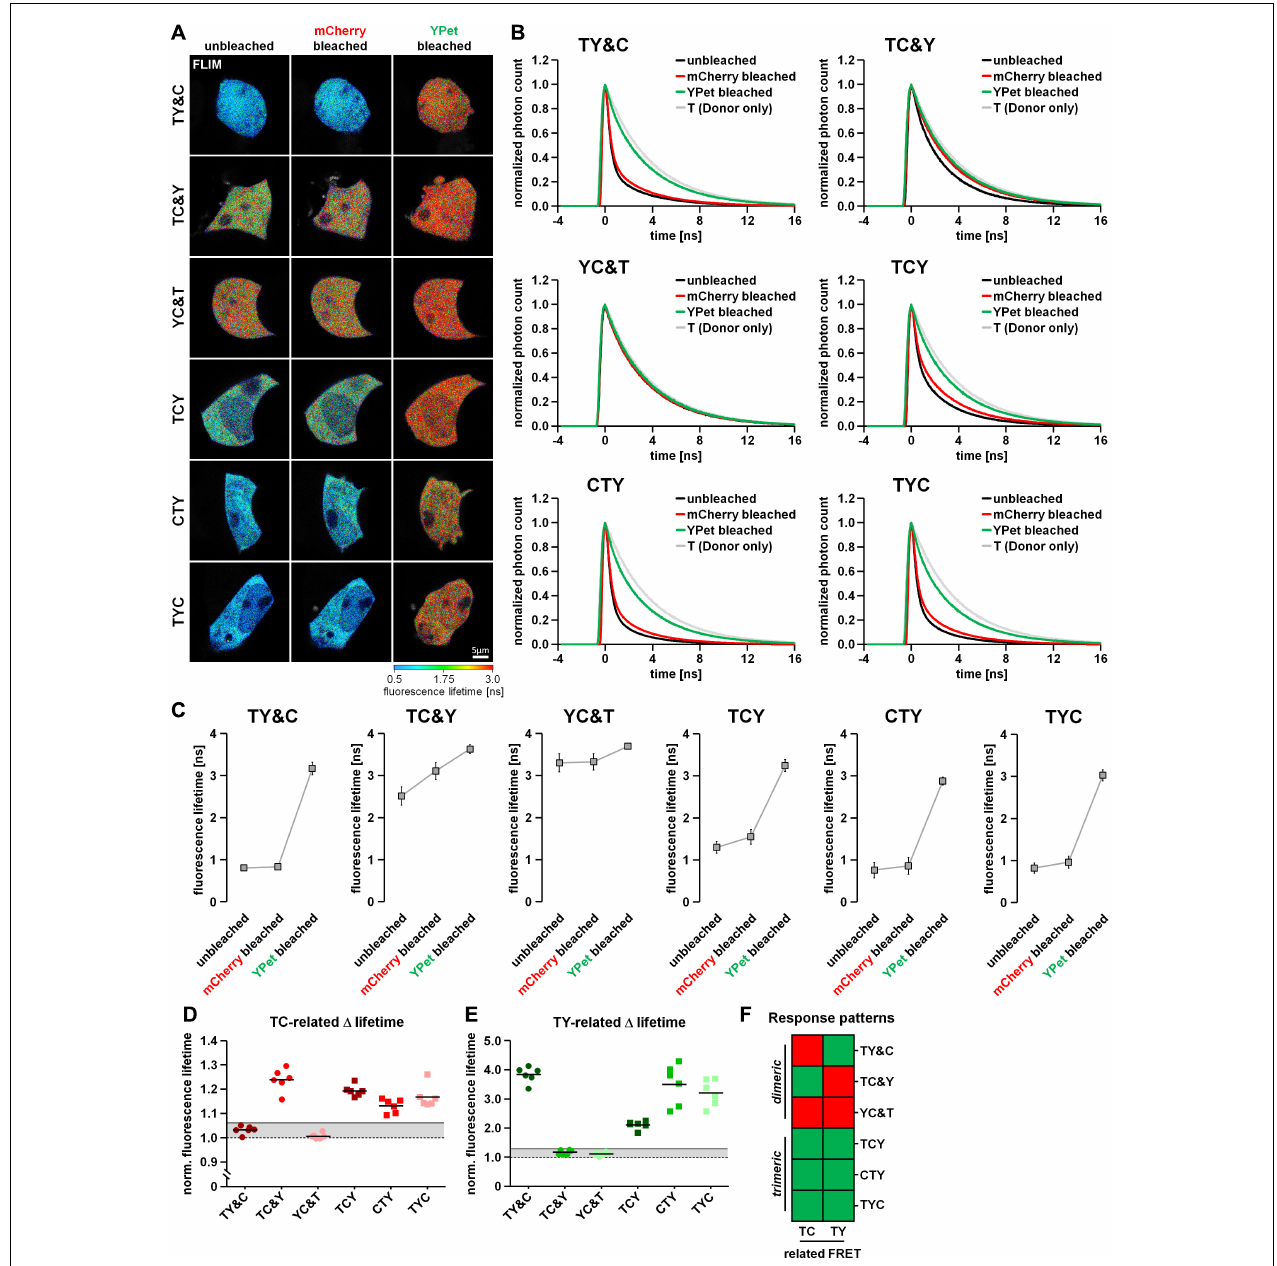
FIGURE 3 | Differentiation of dimeric and trimeric interactions using fluorescence lifetime-based measurements. (A) HEK293T cells transfected with either the FRET triplet constructs (TCY, CTY, TYC) or the FRET doublets with their respective missing fluorophore (TY&C, TC&Y, YC&T). Representative images show the color-coded fluorescence lifetime of mTurquoise2 before bleaching (unbleached), after the first bleaching step (mCherry bleached) and after the second bleaching step (YPet bleached). (B) Average profiles of mTurquoise2 fluorescence decay ( n = 6). Note the sequential reversion of the FRET-induced left shift of mTurquoise2 fluorescence decay after the first and the second bleaching step. (C) Change in average amplitude weighted lifetime of the cells during the two-step bleaching protocol ( n = 6). After mCherry bleaching, the fluorescence lifetime increased moderately in TC&Y and slightly in TCY, CTY and TYC samples, whereas it remained rather constant in TY&C and YC&T samples. In contrast, after YPet bleaching, the fluorescence lifetime increased drastically in TY&C, TCY, CTY and TYC, whereas in TC&Y and YC&T samples only a moderate increase was observed. Note the different basal fluorescence lifetime depending on the combination and composition of the FRET constructs. (D,E) Relative change in fluorescence lifetime of mTurquoise2 after mCherry bleaching [TC-related (cid:49) lifetime, (D) ] and the additional relative change in fluorescence lifetime after YPet bleaching [TY-related (cid:49) lifetime, (E) ] ( n = 6). Gray lines indicate threshold values to discriminate FRET-specific from non-specific lifetime changes of the donor. (F) Color coded response pattern of fluorescence lifetime-based measurements. For each matrix, a Yes-response (occurrence of specific FRET) is indicated by a green and a No-response (no or non-specific FRET) is indicated by a red square. According to these patterns, dimeric interactions (FRET doublets) can be clearly discriminated from trimeric interactions (FRET